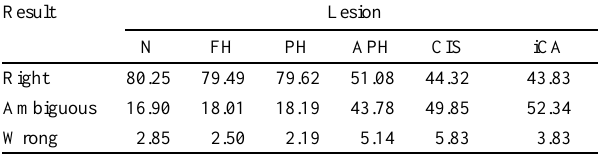
Percentages of nuclei classified by best 5-layer network, broken into lesions